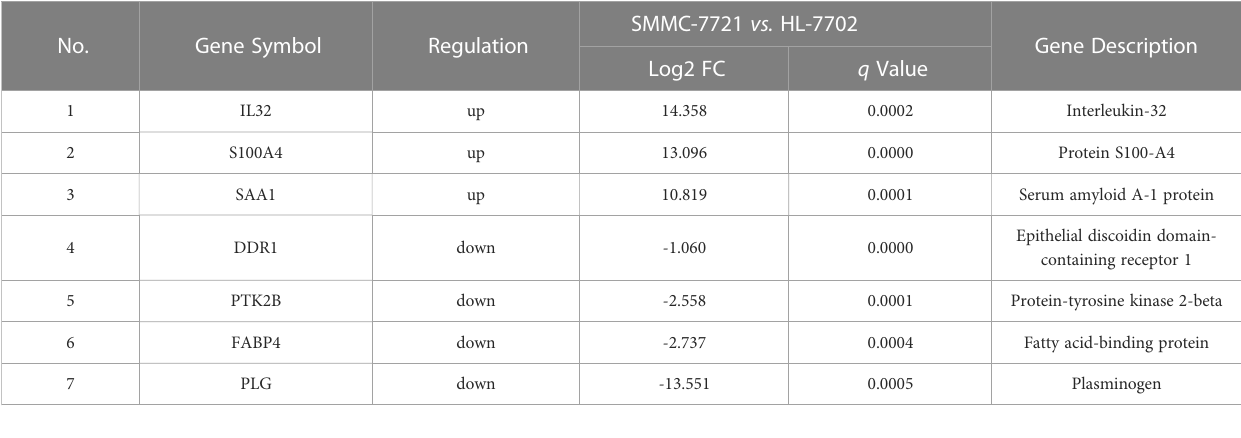
TABLE 3 Differentially expressed genes (DEGs) associated with HCC metastasis.